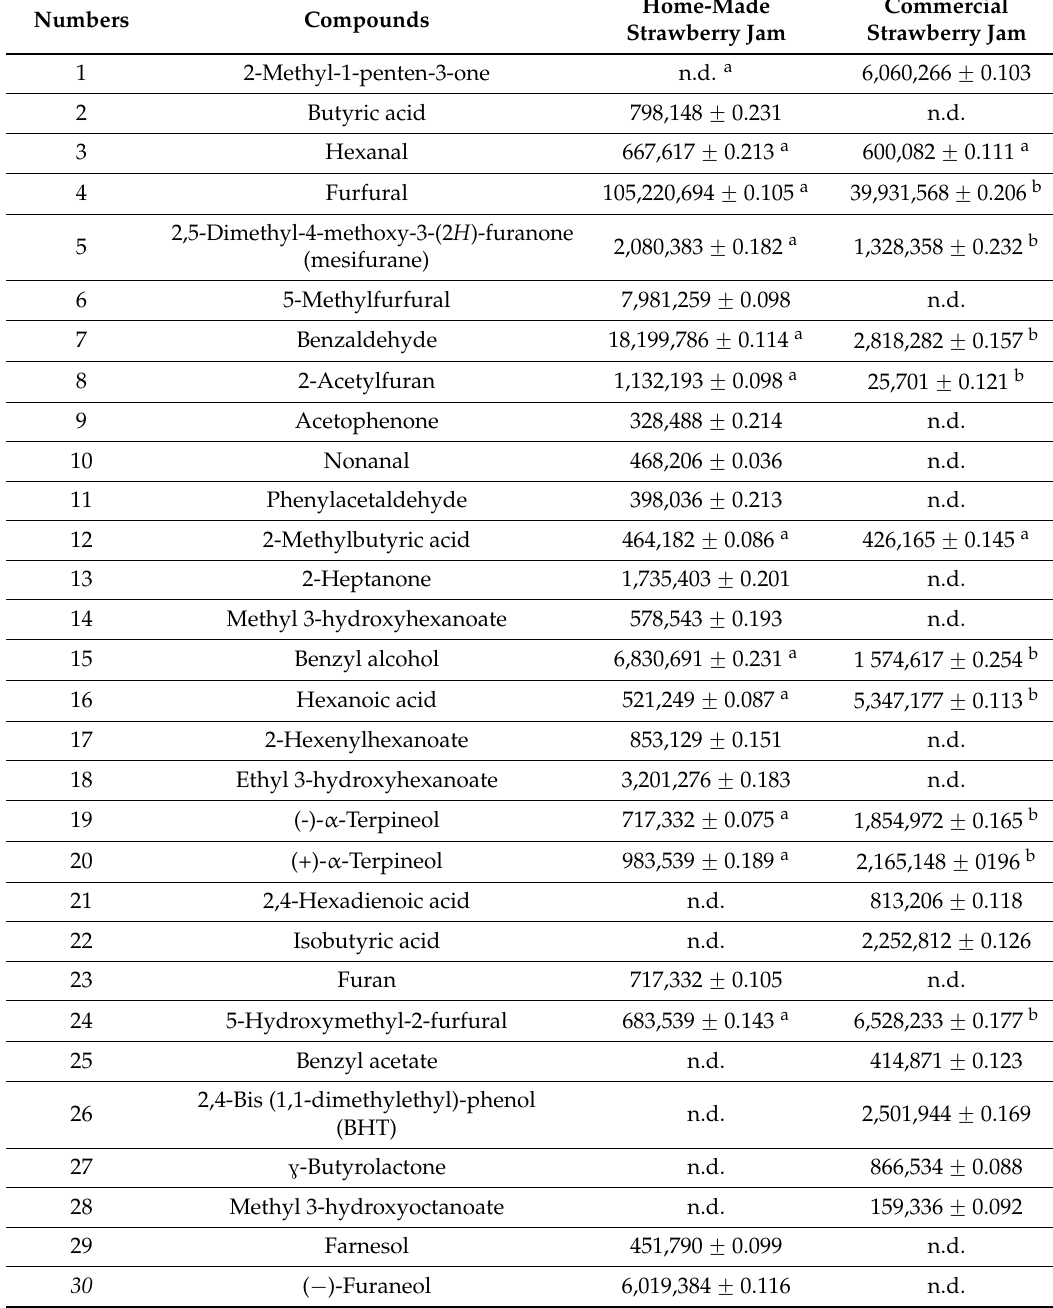
Table 2. Absolute areas of volatile compounds identified in home-made and commercial strawberry jams by the SPME-GC-MS method developed and the experimental conditions selected ( i.e. , CAR/PDMS fibre, 60 ˝ C, 60